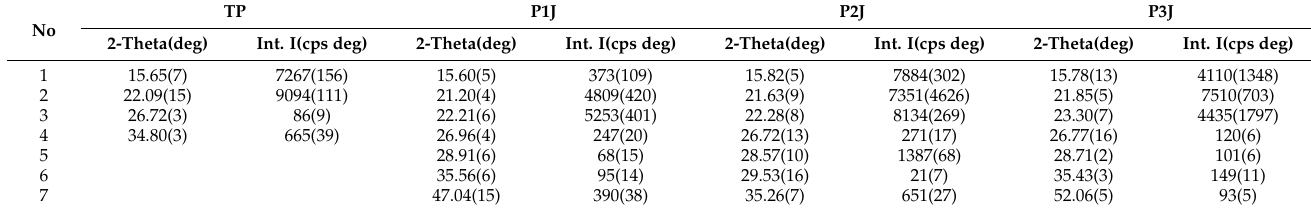
Table 3. Peak list 2-theta(deg) and crystal intensity on Banana Stem Fiber.